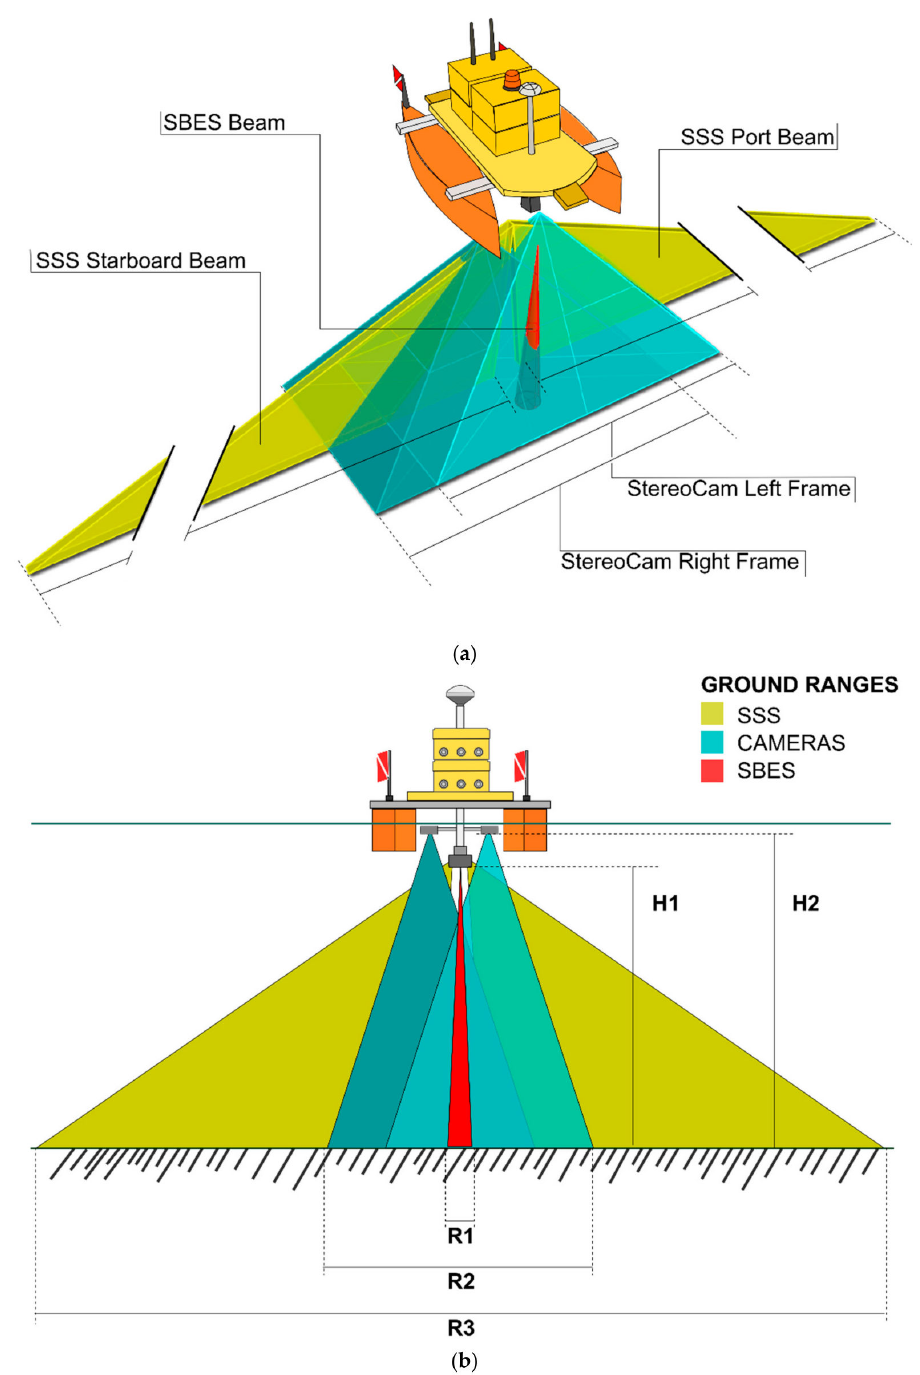
Figure 9. Sketches of ground ranges of acoustical and photogrammetric sensors (figure not in scale): ( a ) 3D reconstruction of the beam opening of the three sensors; and ( b ) 2D reconstruction of the beam opening of the three sensors. R1 is 0.139H1 (with an opening angle of the acoustic beam of 8 ◦ ); R2 is 1.87H2 + b (where b is the stereoscopic base); and R3 can be set with the SSS software (Starfish Scanline V2.1) and varies between 4 and 300